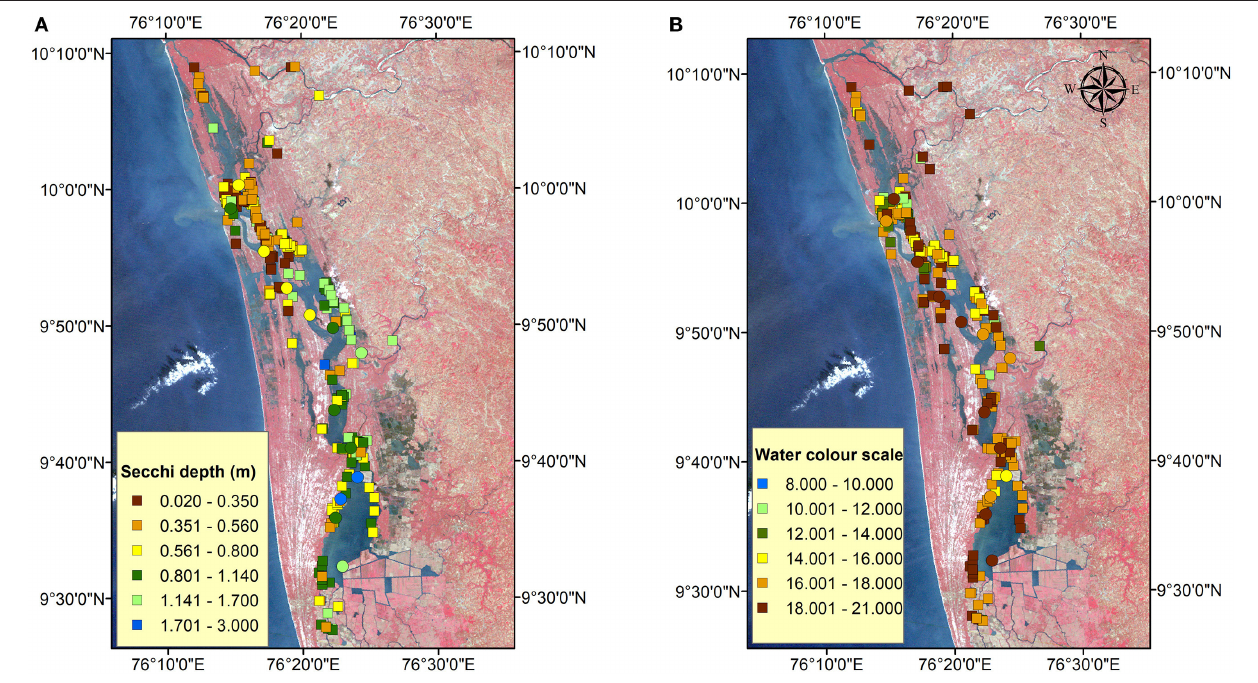
FIGURE 6 | (A) Secchi depth observations and (B) water colour codes obtained from the measurements of both scientists from 13 locations as well as citizens in the Vembanad Lake for 17 months of citizen science activity during August 2019–December 2020. Circles represent the measurements by scientists and squares represent citizens’